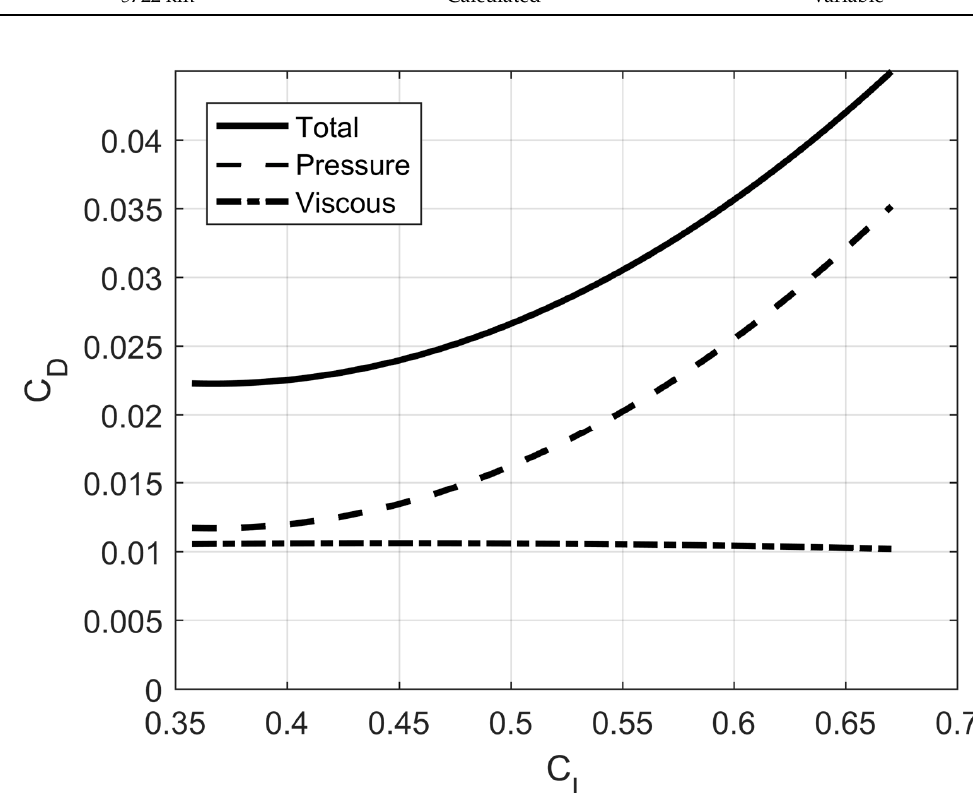
Figure 14. Drag polar curve of the box-wing aircraft studied in the project PARSIFAL ([45]).